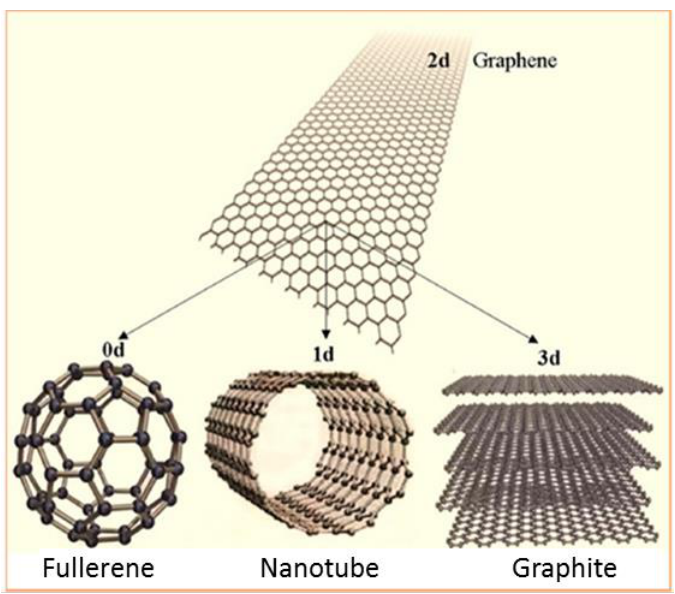
Figure 7. Different allotropes of carbon: graphite (3D); graphene (2D); nanotubes(1D); and fullerene (0D) Reprinted from reference [147].